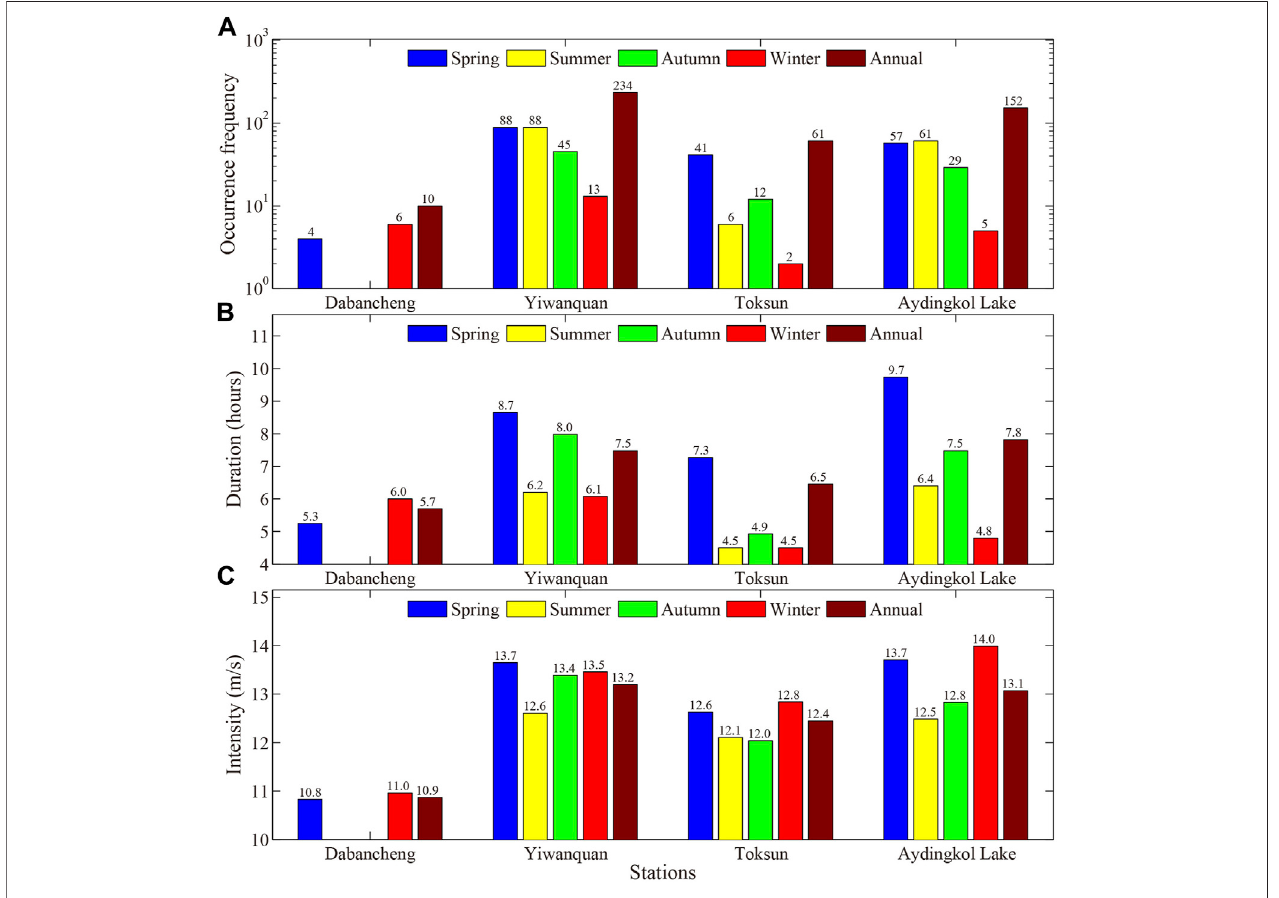
FIGURE 6 | Seasonal and annual (A) occurrence frequency, (B) duration, and (C) intensity of SHWEs at the four stations in southern TGC.